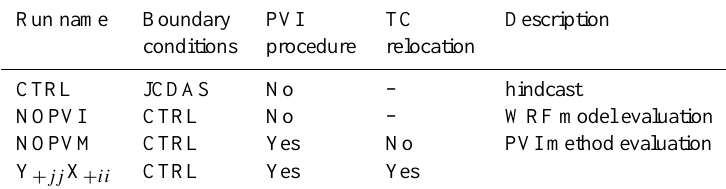
Table 2. Specifications of